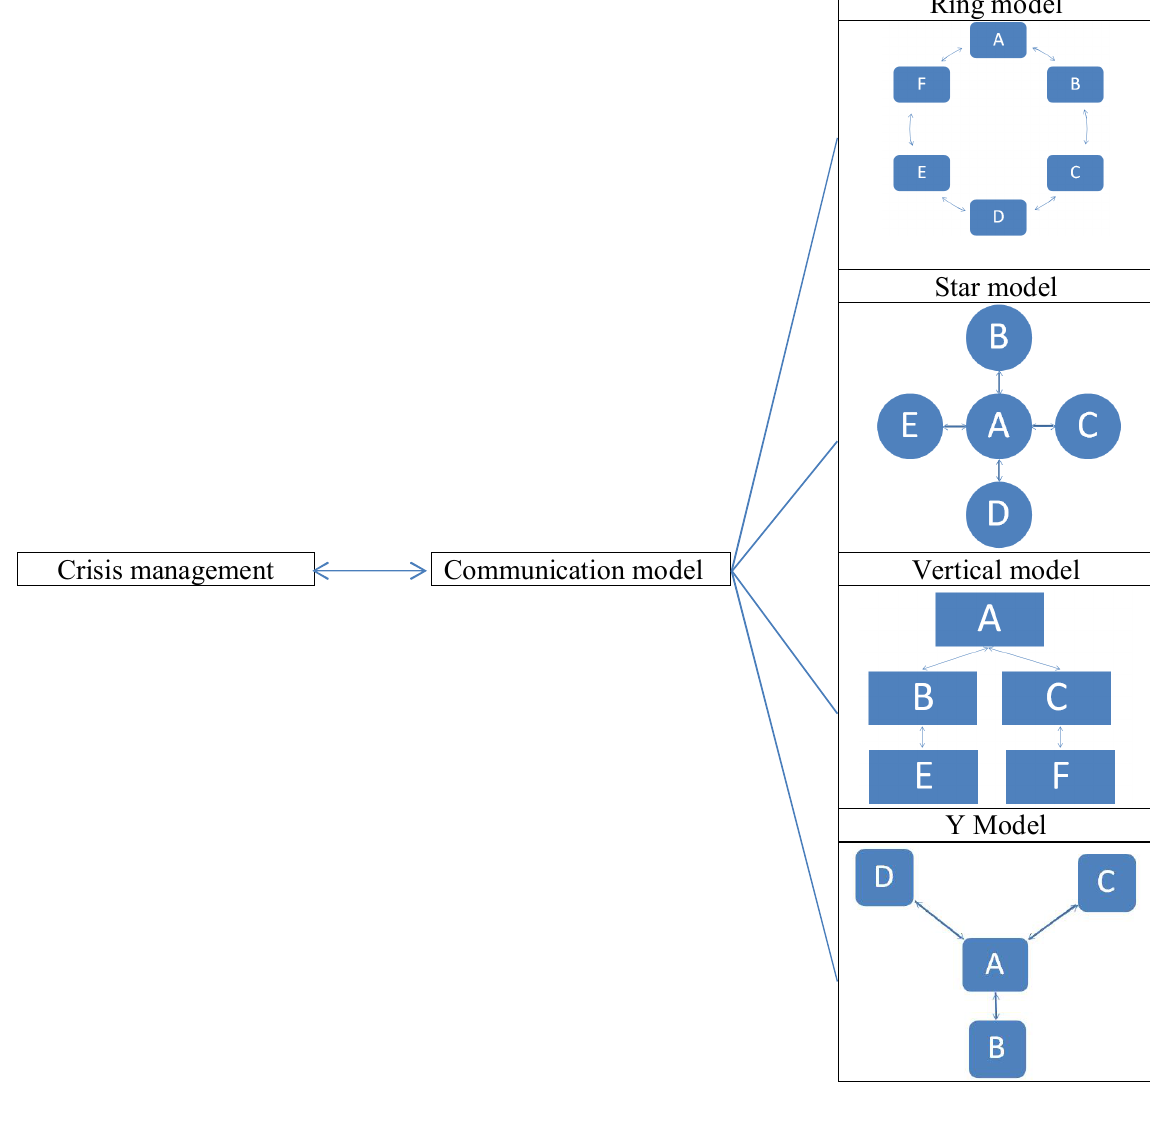
Fig. 1. Operational model of research: communicational models and crisis management.